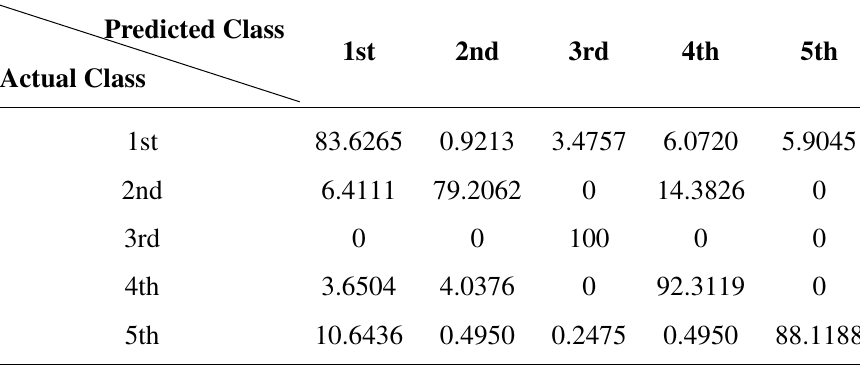
Table 8. Confusion matrix for NN with 10 neighbors, mean shift-filtered patches, 500 × 500-pixel patches and parameter Set IV (values in